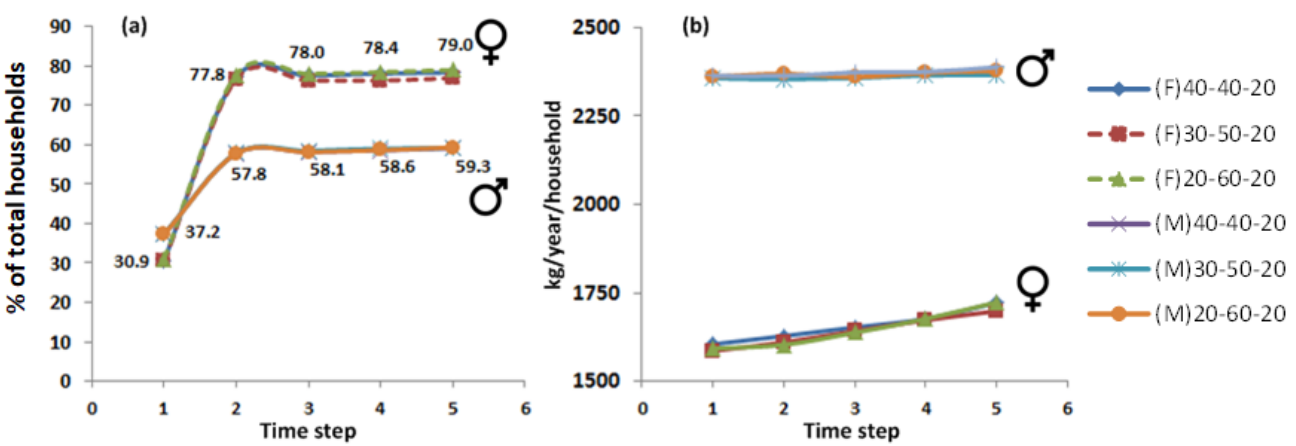
Figure 4. Percentages of households collecting cattle dung ( a ) and mean amounts of cattle dung collected ( b ) according to the gender of household heads by labor allocation under normal population growth (2.5%) .